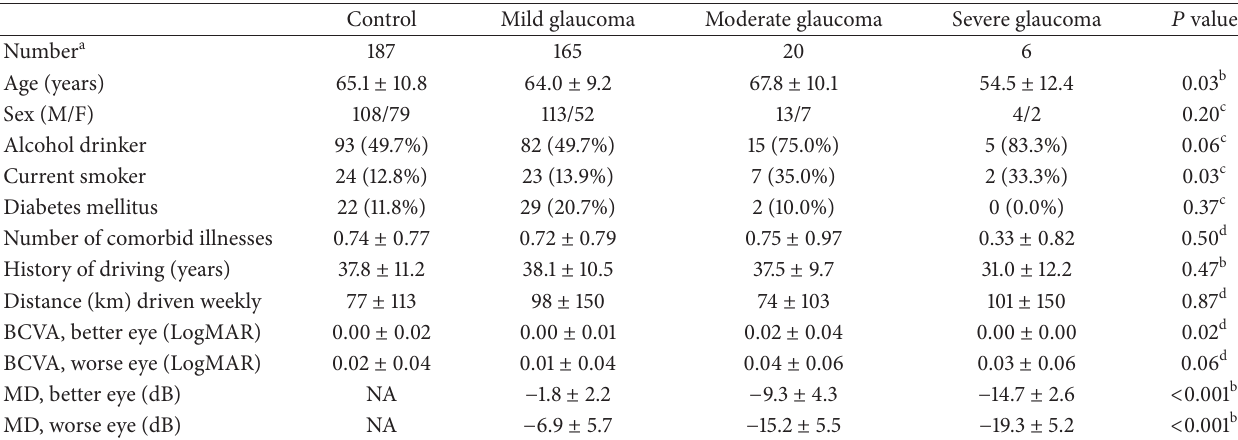
Table 3: Demographic characteristics, grouped by IVF MD.